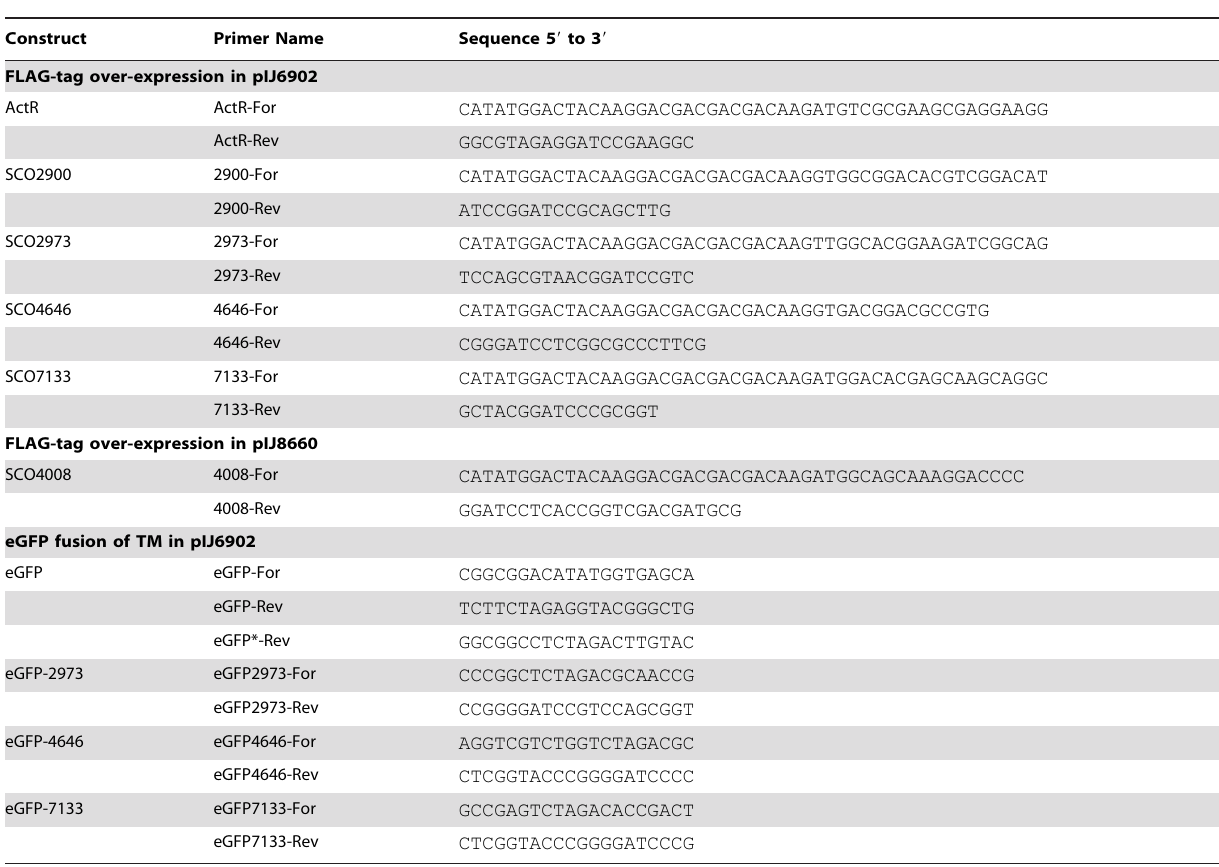
Table 2. Primers used in this